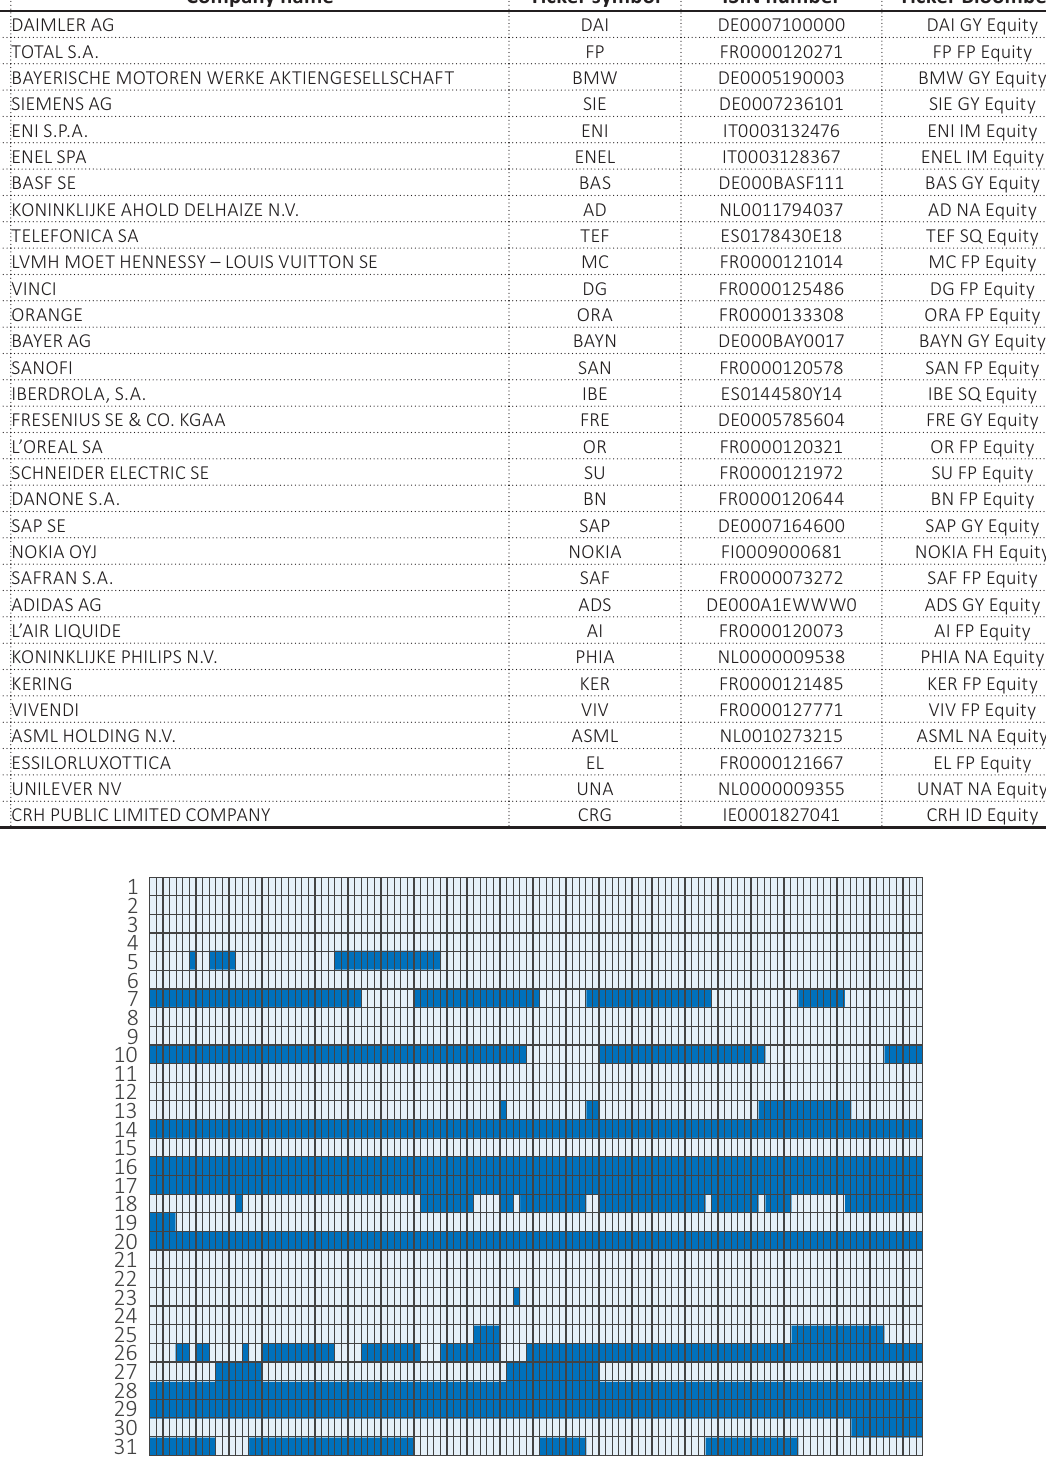
Table 2. List of 31 assets belonging to the investment universe considered No.